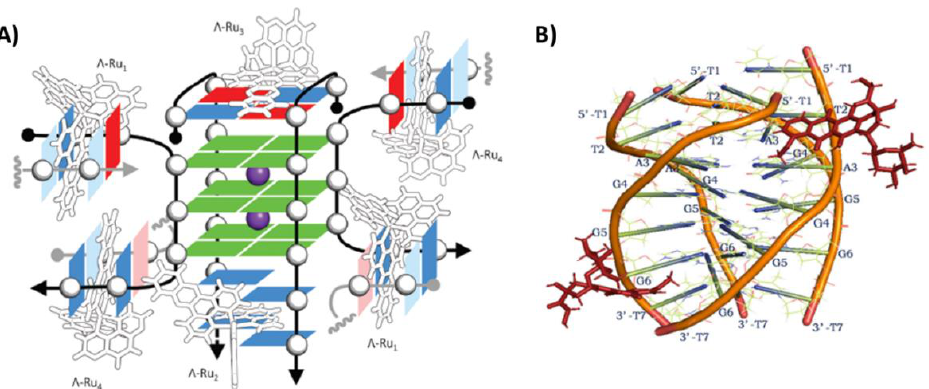
Figure 6. ( A ) Crystal structure of the complex between the parallel tetramolecular G-quadruplex h-tel7 of sequence d(TAGGGTT) and Λ -[Ru(TAP) 2 (dppz)] 2+ [62]. ( B ) NMR structure of the complex between the parallel tetramolecular G-quadruplex h-tel7 of sequence d(TTAGGGT) and adriamycin [64]. 5′ - and 3′ -ends of the G-quadruplex are at the top and bottom, respectively. Adapted with per-mission from refs. [62,64], Copyright 2019 The Royal Society of Chemistry and Copyright 2021 Tay- lor & Francis.